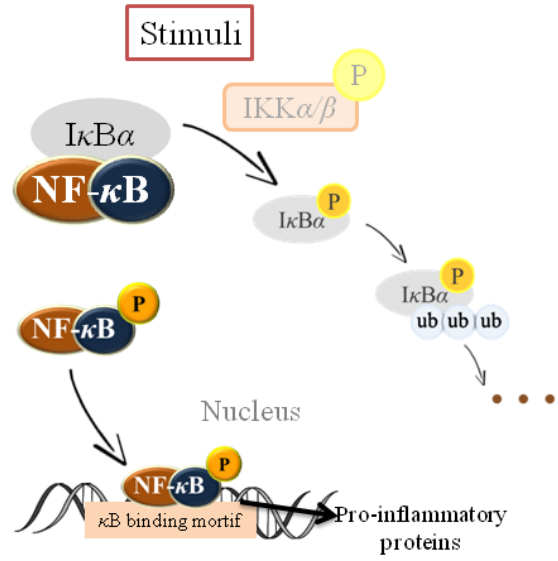
Figure 2. Inflammatory responses to a wide variety of stimuli mainly attribute to up-regulation of the proinflammatory transcription factor - nuclear factor kappa B (NF- κ B). Since it is a kind of redox-sensitive transcription factor, NF- κ B responses to a number of stimuli including reactive oxygen species under normal circumstances, NF- κ B is sequestered in the cytoplasm by binding to the inhibitory protein called inhibitor of kappa B (I κ B). Besides, the I κ B kinase (IKK) complex is the signal integration hub for NF- κ B activation, its main role is integrating signals from all NF- κ B activating stimuli to catalyze the phosphorylation of various I κ B and NF- κ B proteins. After activation by stress, diet alteration, free radicals, inflammatory stimuli, cytokines and the presence of carcinogens, NF- κ B translocates to the nucleus, and then induces the expression of different inflammatory cytokines and many other genes related to cellular transformation, invasion, metastasis and